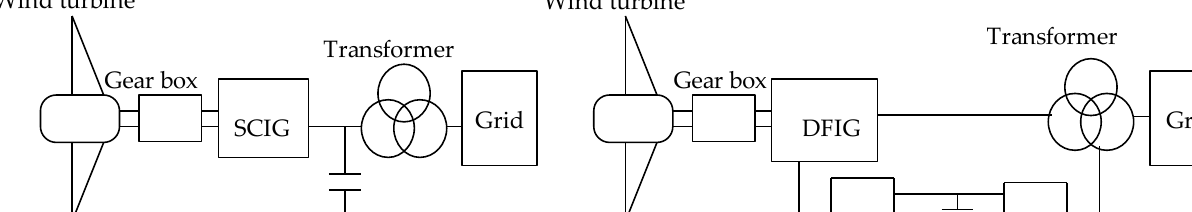
Figure 1. Main components of grid-connected wind energy sources .